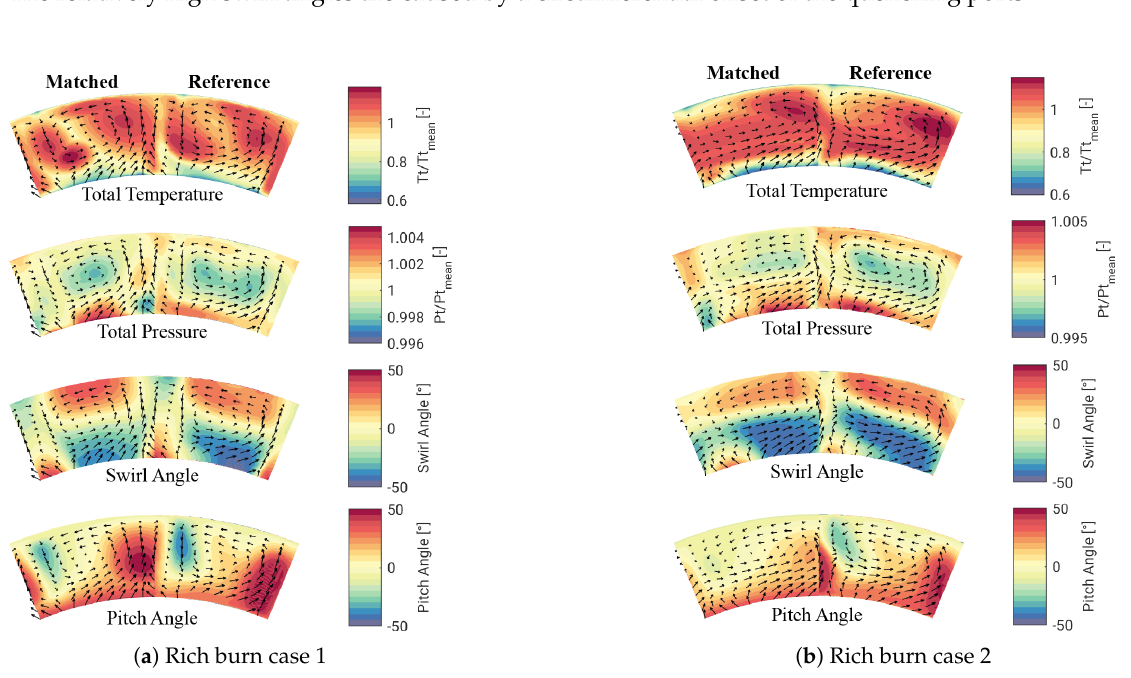
Figure A4. Results of additional rich burn test